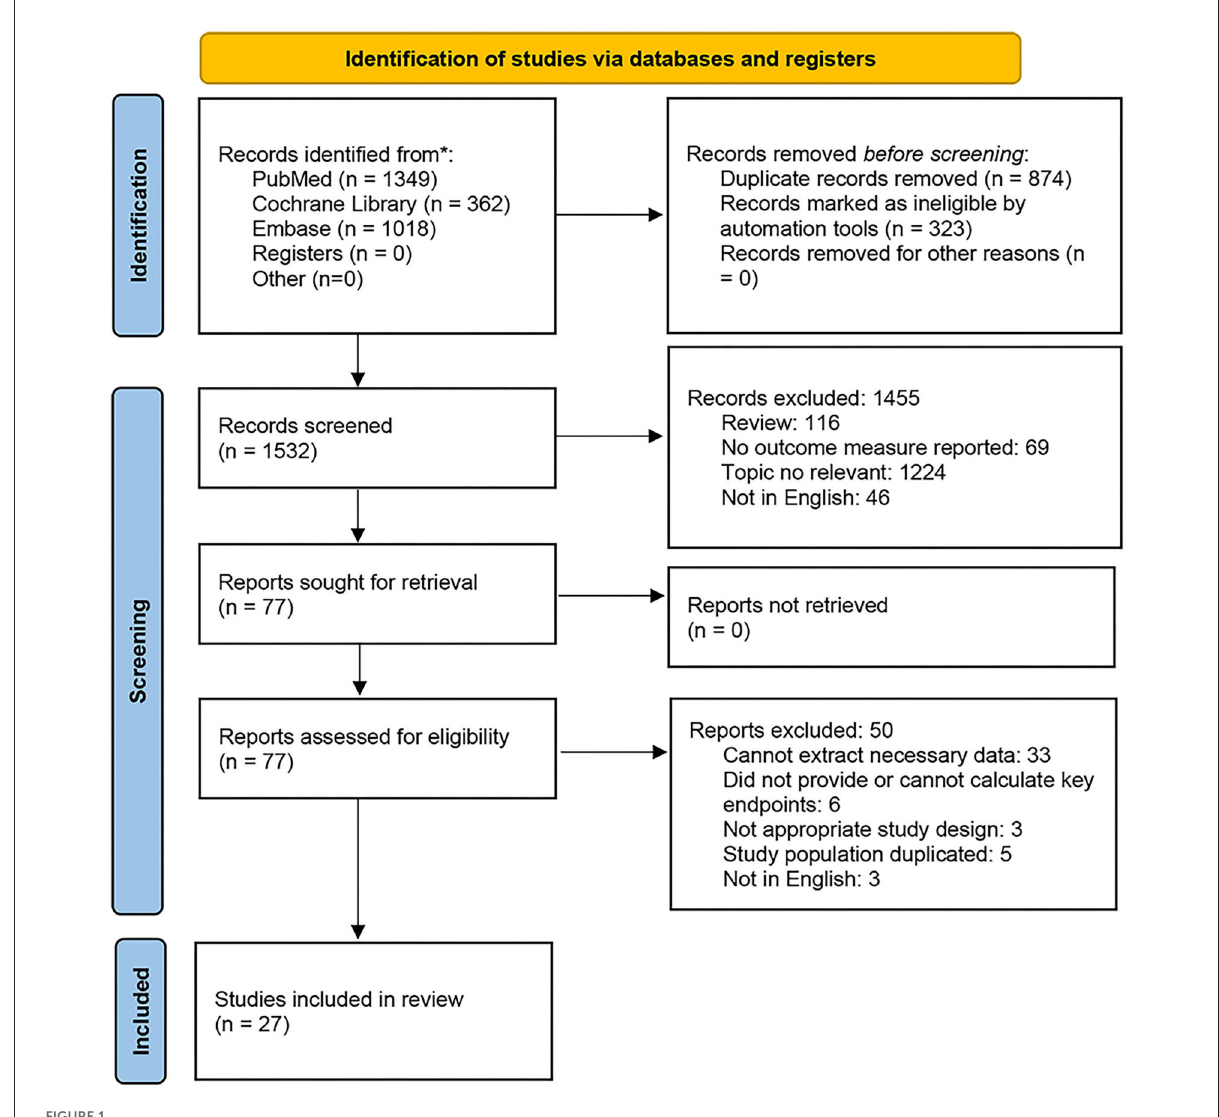
FIGURE1 Flowchart of the study